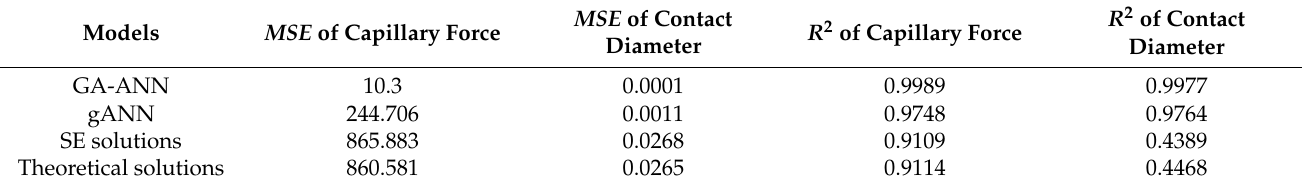
Table 3. Values of MSE and R 2 for different